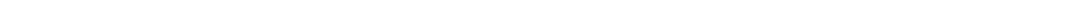
(see fi gure on previous page) Fig. 7 EP4 mediated cartilage anabolism through regulation of the Sox9 expression by cAMP/PKA/CREB signaling. a Primary culture of articular chondrocytes was treated with or without 1 ng/ml IL-1 β , and the indicated concentrations ( μ M) of HL-43 for 24 h. Col2a1 and GAPDH protein levels were detected by Western blotting. b Activation of the 4 × 48-p89-Luciferase reporter by HL-43 in a dose-dependent manner in ATDC5 cells, n = 3. c , d HL-43 increased the Sox9 transcriptional activity. After transfected with the Sox9 promoter-Luc reporter, ATDC5 cells treated with ( d ) or without ( c ) 2 ng/ml IL-1 β and indicated concentrations ( μ M) of HL-43 for 6 h. The cell lysates were subjected to a Dual-Luciferase assay, n = 3. e HL-43 activated the CRE-Luc reporter. ATDC cells were transfected with the CRE-Luc reporter and treated with or without 2 ng/ml IL-1 β , 100 nM PGE2, and indicated concentrations ( μ M) of HL-43 for 6 h, the cell lysates were subjected to a Dual-Luciferase assay, n = 3. f , g HL-43 increased the phosphorylation of CREB through EP4. Chondrocytes isolated from new born EP4 f/f mice ( f ) or EP4 Col2 mice ( g ) were treated with 2 ng/ml IL-1 β , 100 nM PGE2, and the indicated concentration ( μ M) of HL-43 for 1 h. p-CREB, CREB, and GAPDH protein levels were detected by Western blotting. Protein bands in the blot were quanti fi ed by densitometry and analyzed using Image J. The numbers indicate grayscale ratios of p-CREB/CREB. h ATDC5 cells were transfected with the CRE-Luc reporter gene. After treated with the 2 ng/ml ml IL-1 β , 10 μ M H89, and 30 μ M HL-43 for 6 h, the cell lysates were subjected to a Dual-Luciferase assay ( n = 3). i HL-43 regulated Sox9 promoter through PKA activity. After transfected with Sox9 promoter-Luc reporter, ATDC5 cells were treated with or without 10 μ M H89 or 30 μ M HL-43 for 6 h. The cell lysates were subjected to a Dual- Luciferase assay, n = 3. j HL-43 increased the phosphorylation of CREB in the DMM surgery-induced CD mouse model (refer to Fig. 6e). Immuno fl uorescent staining of p-CREB and CREB in the knee joint sections. Scale bars, 50 μ m. Dotted lines indicated the surface of articular cartilage. k The cAMP induced by HL-43 for 2 h in primary articular chondrocytes was measured, n = 3. Error bars are means ± s.d, * P < 0.05, ** P < 0.01, *** P < 0.001, **** P < 0.0001 by one-way ANOVA with multiple comparison using Tukey method. ns not signi fi